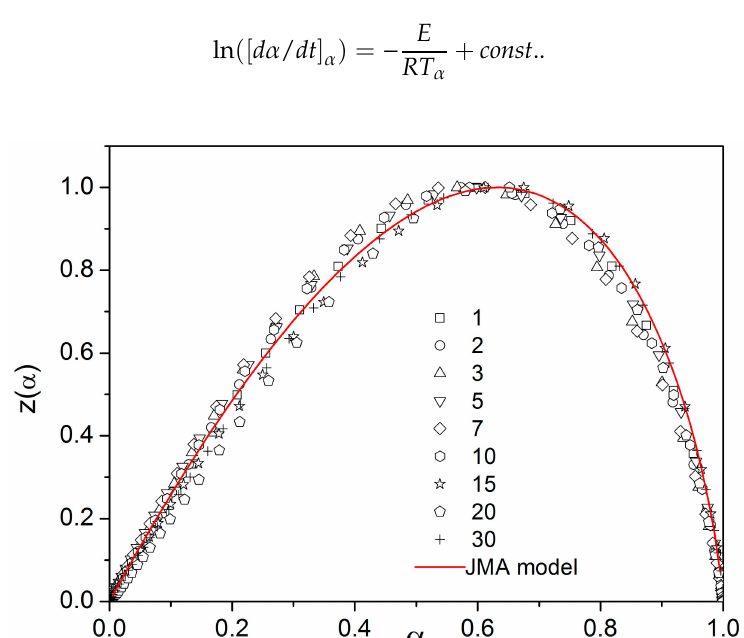
Figure 6. The z( α ) function obtained by transformation of DSC data shown in Figure 5. Points were calculated by using Equation (11) (numbers indicate heating rate). The full line was calculated by Equation (12).